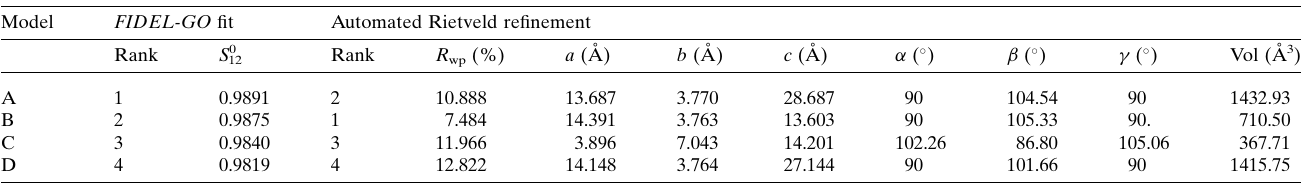
Table 1 Result of the structure solution by a global fit with FIDEL-GO. S 0 12 denotes the similarity measure after structure solution. For details on S 0 12 see Habermehl et al. (2022). Additionally, the result of the automated Rietveld refinement is shown